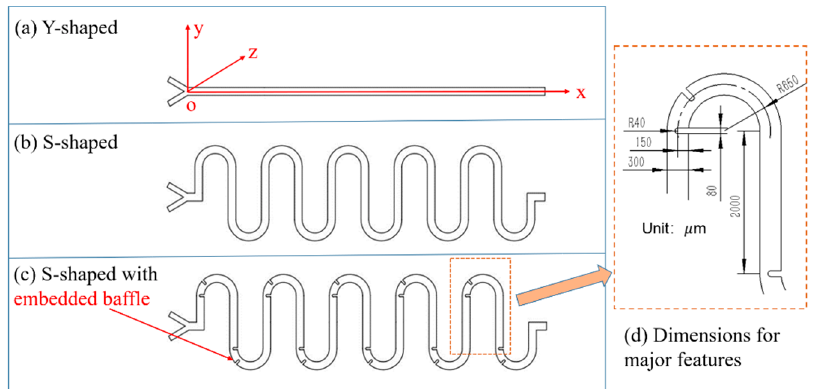
Table 2. Parameters of fluids in the simulations.